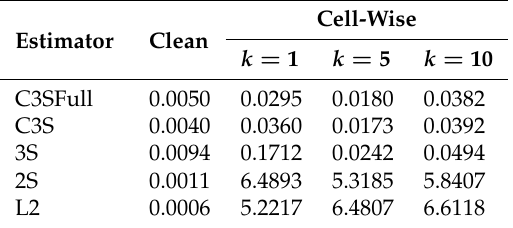
Table 4. MSE for the indicated estimator with clean data and cell-wise contaminated data. Estimator